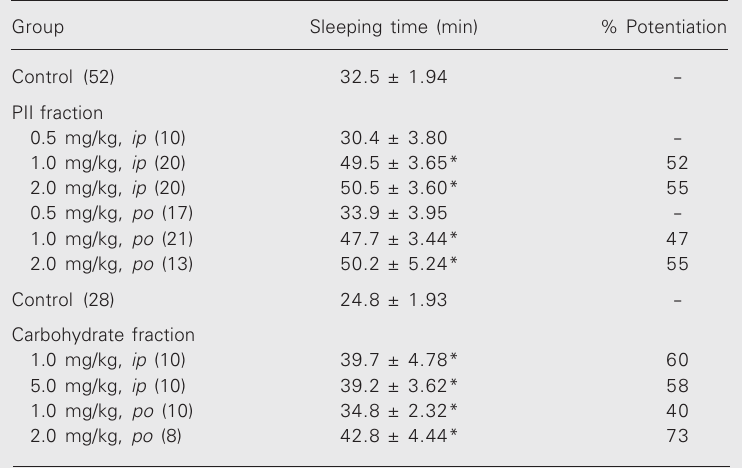
Female Swiss mice were used. Distilled water (10 ml/kg) was used as control. Data are reported as mean ± SEM for the number of animals indicated in parentheses.